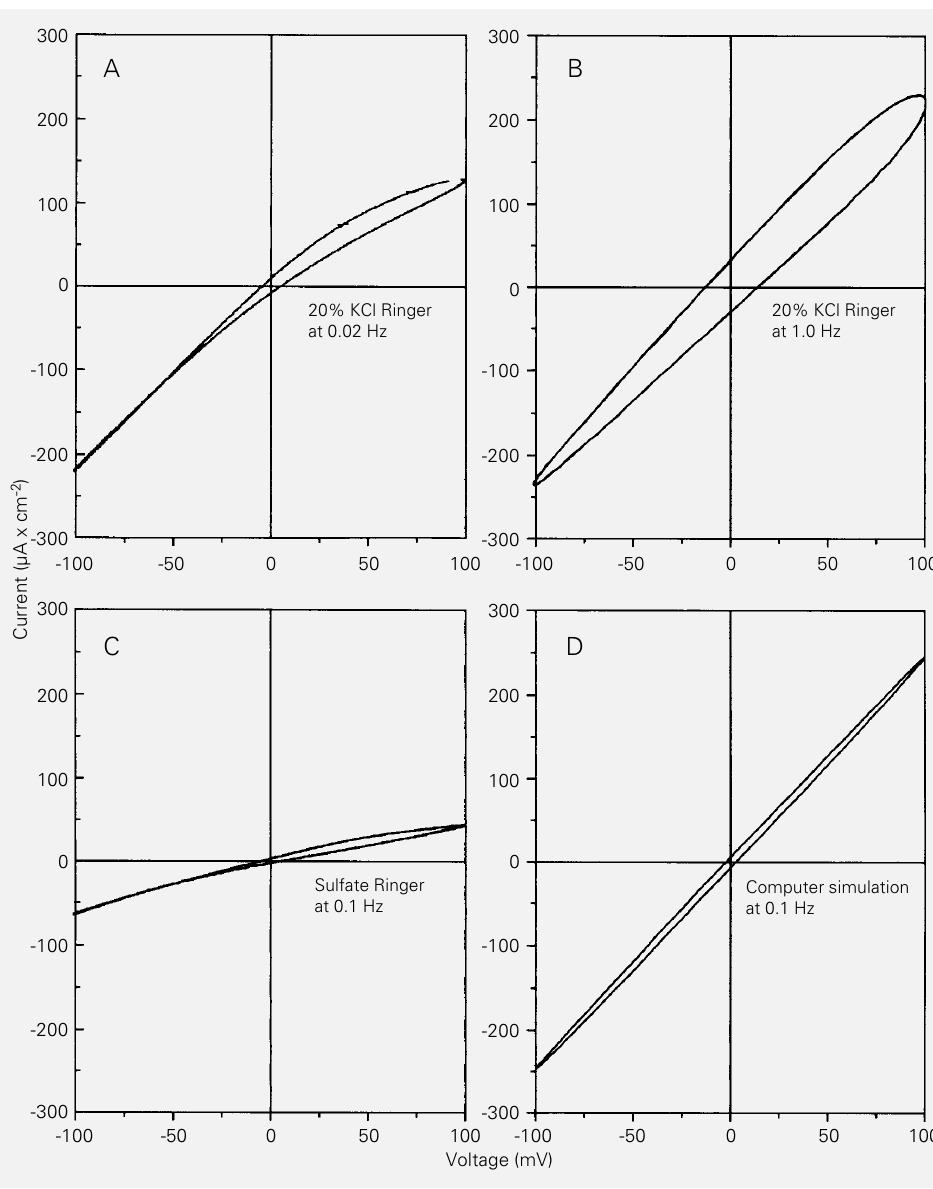
ent in the I vs V plots. The vertical distance